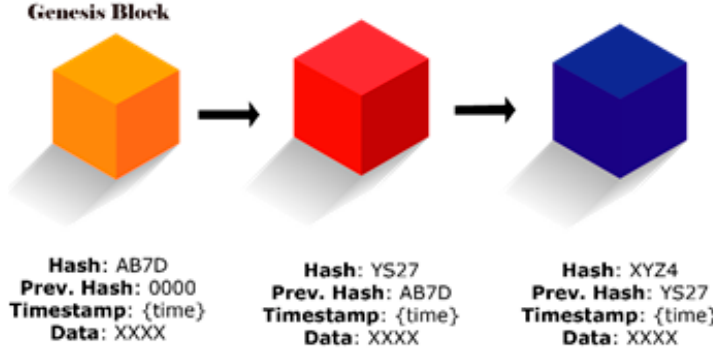
Figure 3. Blocks data security and linking in blockchain technology.